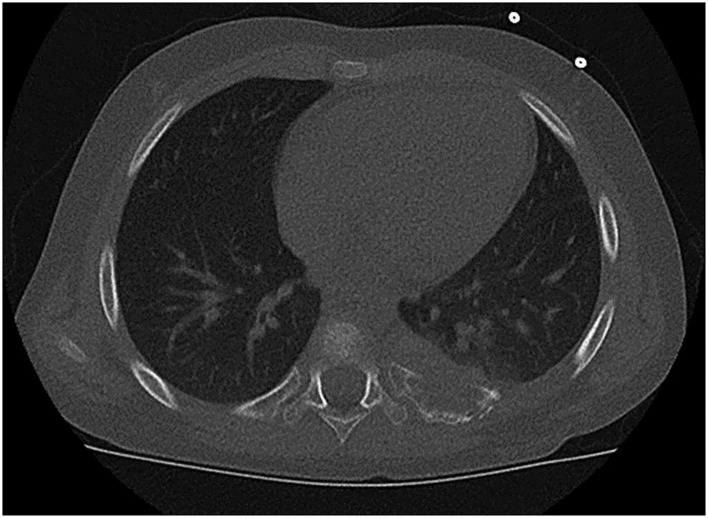
Tumor arising from the paravertebral dorsal portion of the left 7th rib with infiltration of the transverse process and vertebral body. This extent required en bloc resection of the ribs 6–8 and additional removal of the costovertebral joint and hemilaminectomy (patient #10).